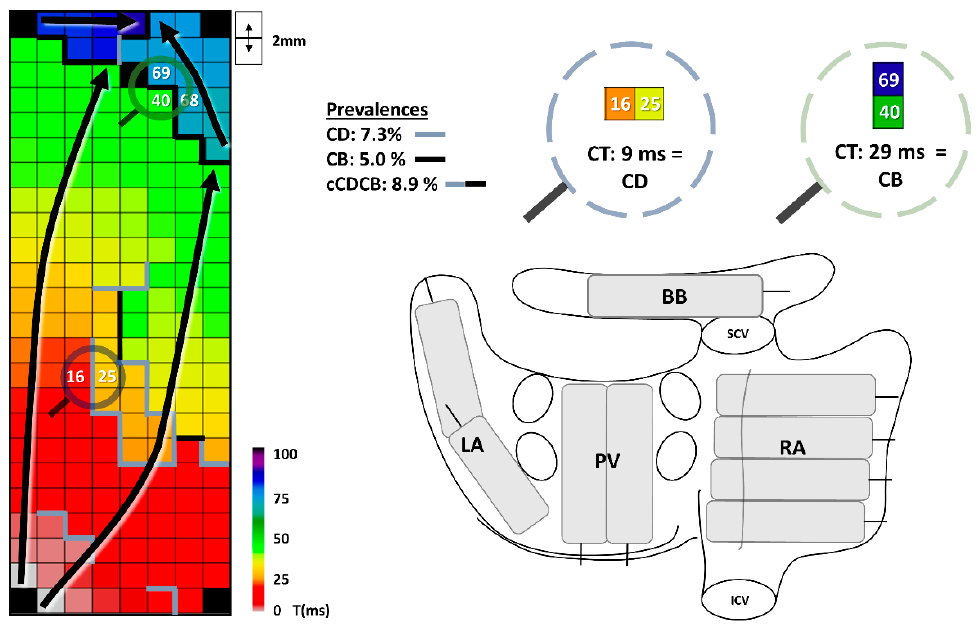
Figure 1. Conduction delay and block. The left panel shows a color-coded activation map of BB with conduction disturbances and arrows showing the direction of wavefront propagation. The upper right panel shows the corresponding prevalences of conduction delay (CD), conduction block (CB) and continuous conduction delay and block (cCDCB). CT: conduction time; the time difference between two electrodes. The lower right panel shows an overview of the mapping locations on a posterior view of the heart. BB: Bachmann’s bundle; ICV: internal vena cava; LA: left atrium; PVA: pulmonary vein area; SCV: superior vena cava; RA: right atrium.